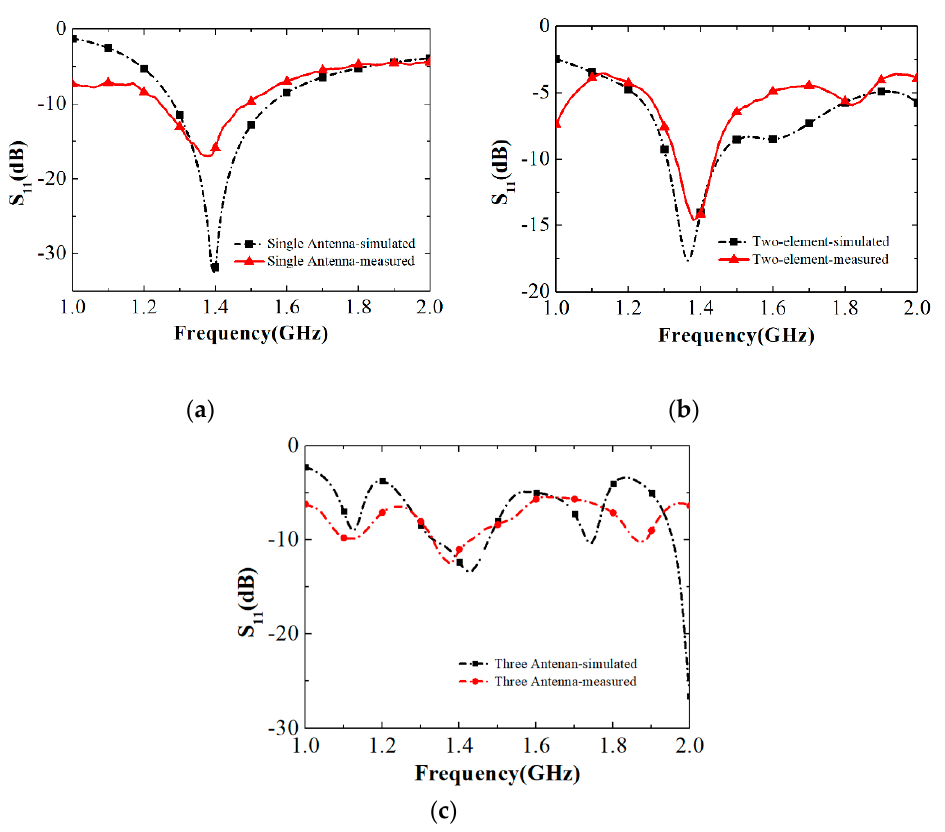
Figure 7. Simulated and measured S 11 for ( a ) the single antenna, ( b ) two-element antenna array, and ( c ) three-element antenna